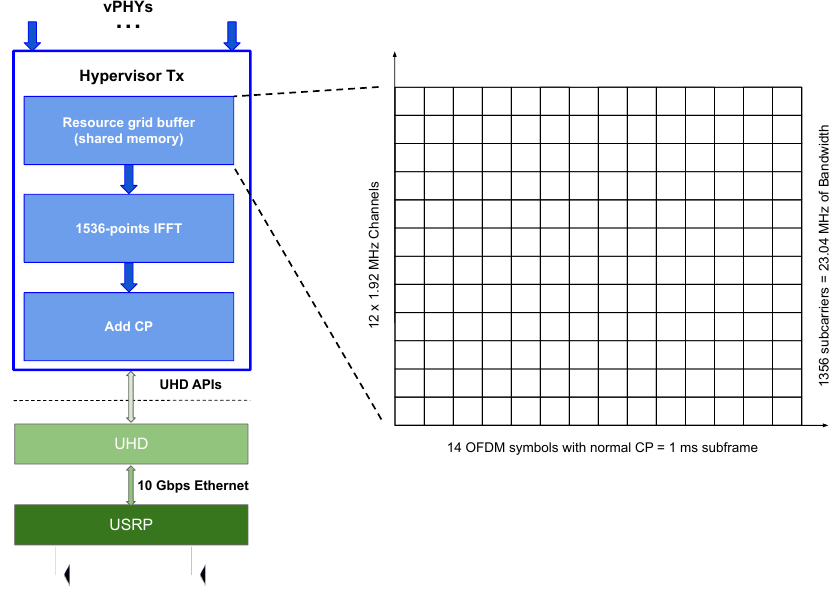
Figure 9. Internal architecture of the Hypervisor Tx